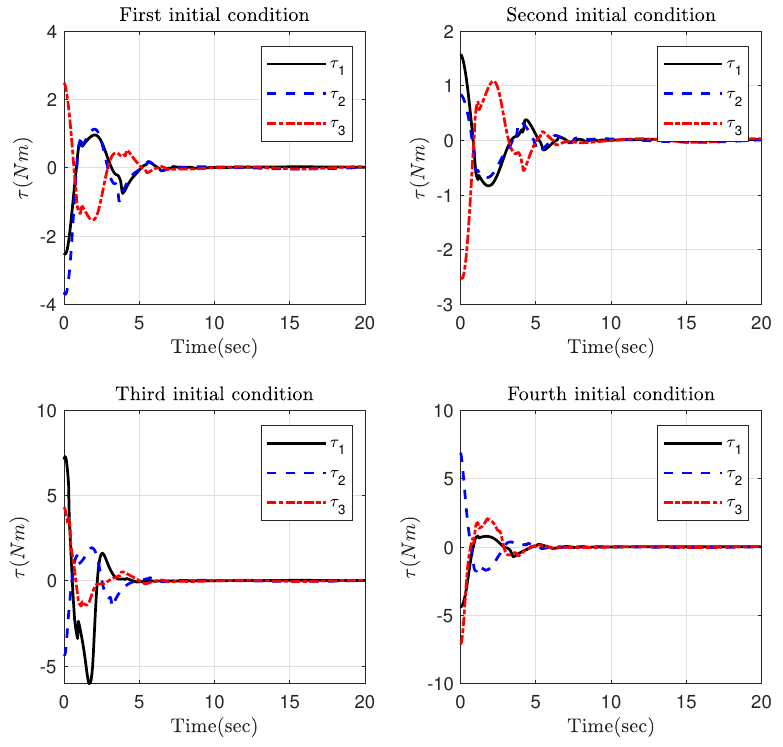
Figure 10. The control torque in Part 1 for different initial conditions.